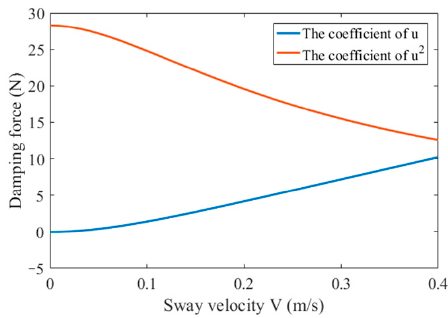
Figure 8. The relation between the damping coefficients of surge motion and the disturbance velocity in sway direction.